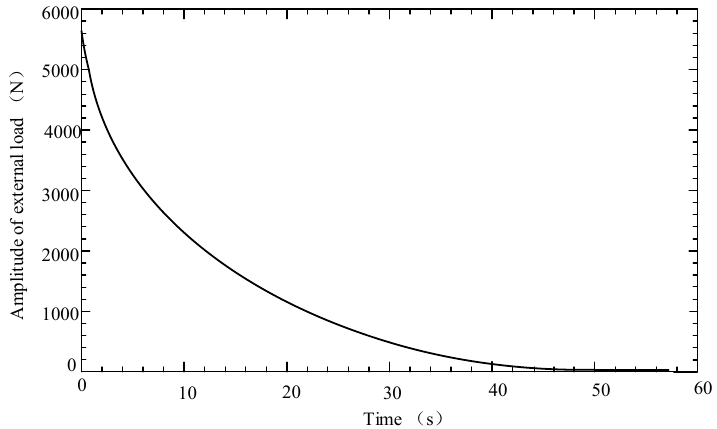
Figure 3. Relationship between external load amplitude and crack initiation time.